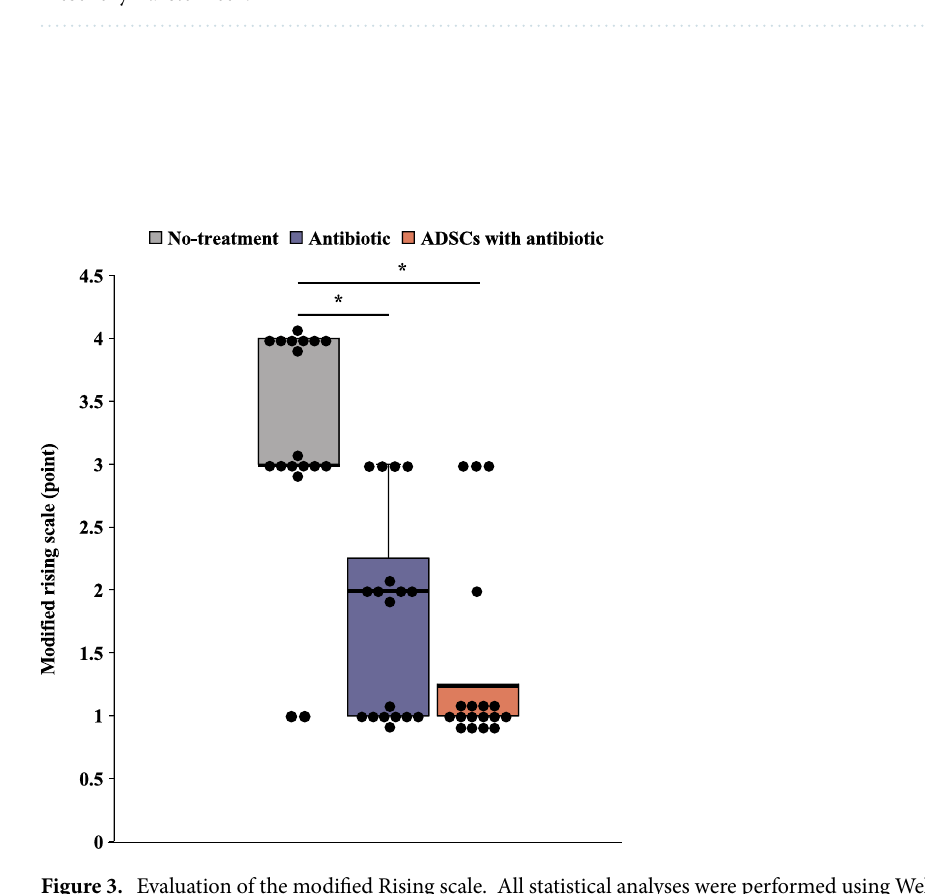
Figure 2. Evaluation of weight change. Weight percent change from pre-operation day 1 baseline values. Weight change was significantly smaller in the ADSCs with antibiotic group than in the other groups on POD7 and POD14. All statistical analyses were performed using Welch ANOVA followed by Tukey HSD post-test (n = 6 rats per group). The error bars are defined as standard error of the mean. *p < 0.05. ADSC adipose-derived mesenchymal stem cell.